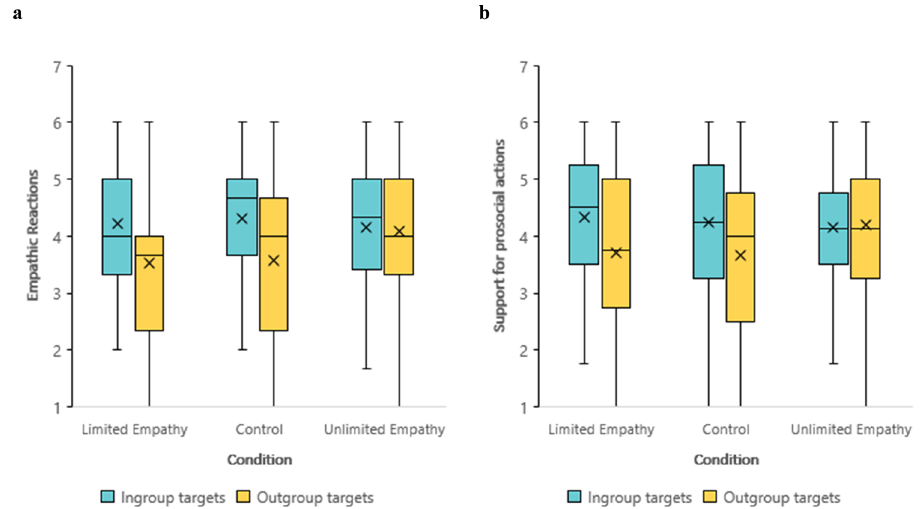
Fig. 3 | Empathic reactions and support for prosocial actions. a Empathic reactions toward ingroup and outgroup targets, as a function of condition (i.e., limited empathy, n =51; unlimited empathy, n =52; and control, n =47). A sig- ni fi cant target identity×conditioninteraction , F (2, 147)=4.50, p =0.013, d =0.5.A signi fi cant difference in empathy toward ingroup and outgroup members in the limited condition ( p <0.001) and in the control condition ( p <0.001). No sig- ni fi cant difference in empathy towards ingroup and outgroup members among participantsintheunlimited condition( p =0.654). b Supportforprosocialactions toward ingroup and outgroup targets as a function of condition (i.e., limited empathy, n =51;unlimitedempathy, n =52;andcontrol, n =47).Asigni fi canttarget